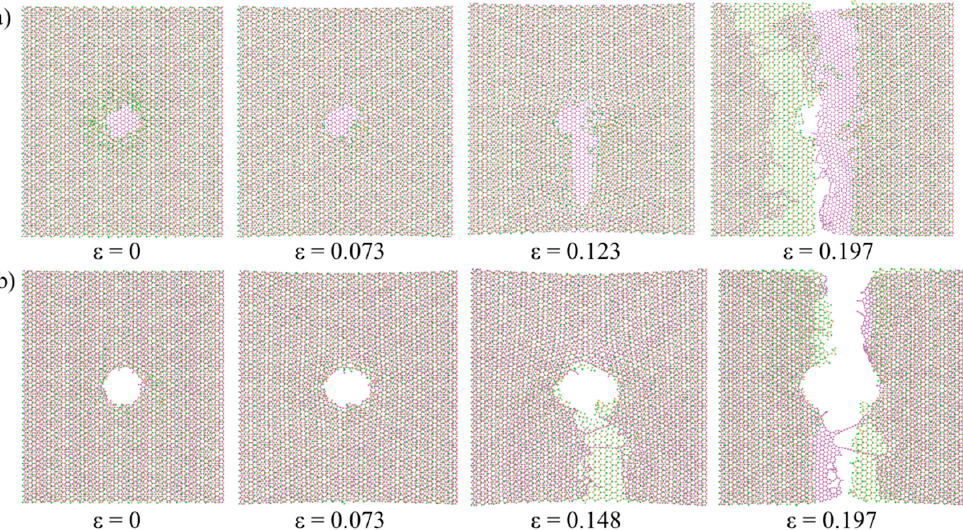
Figure 13. Dynamics of structural evolution of the M/G heterostructure nanopore under ion irradiation with irradiation parameters of ( a ) 80 eV, 3.18 × 10 15 /cm 2 and ( b ) 400 eV, 1.27 × 10 16 /cm 2 .